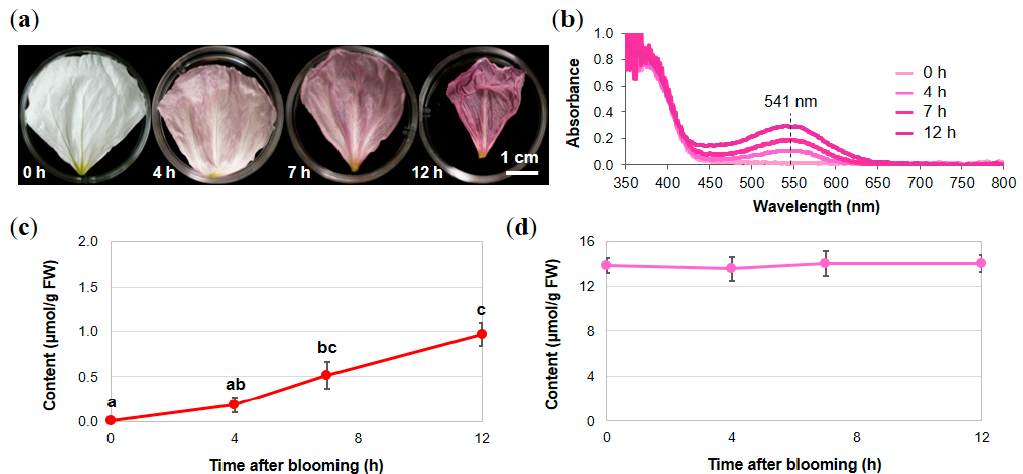
Figure 4. Changes in the color and flavonoid components of the petals of O. tetraptera during senescence. ( a ) Petal color at each stage, ( b ) reflection spectra, ( c ) change in the Cy3G ( 1 ) content, and ( d ) change in the quercitrin ( 2 ) content. The data displayed are the means ± SE of three replicates ( n = 3). Where no error bars are shown, the SE was too small to determine. Different letters indicate significant differences according to Tukey’s HSD test ( p < 0.05).